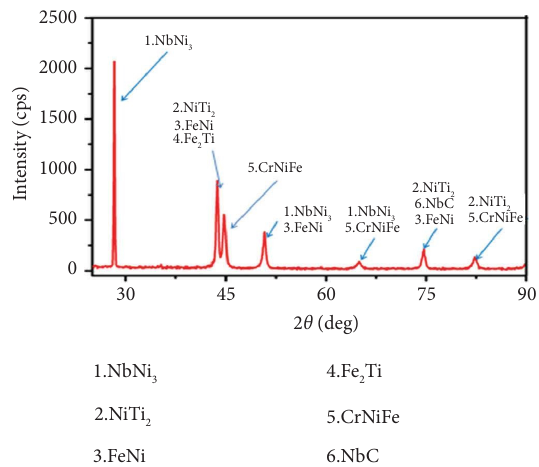
Figure 13: XRD pattern identifed across the Inconel 718 and AISI 410 martensitic.